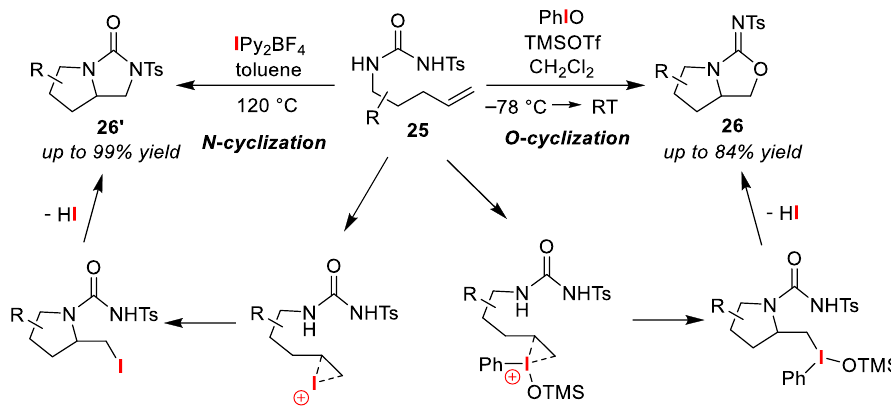
Figure 14. Synthesis of bicyclic iso-ureas 26 and ureas 26′ via O / N atom-selective iodo-cyclizations of olefinic N -tosyl-ureas 25 using different active iodine species.